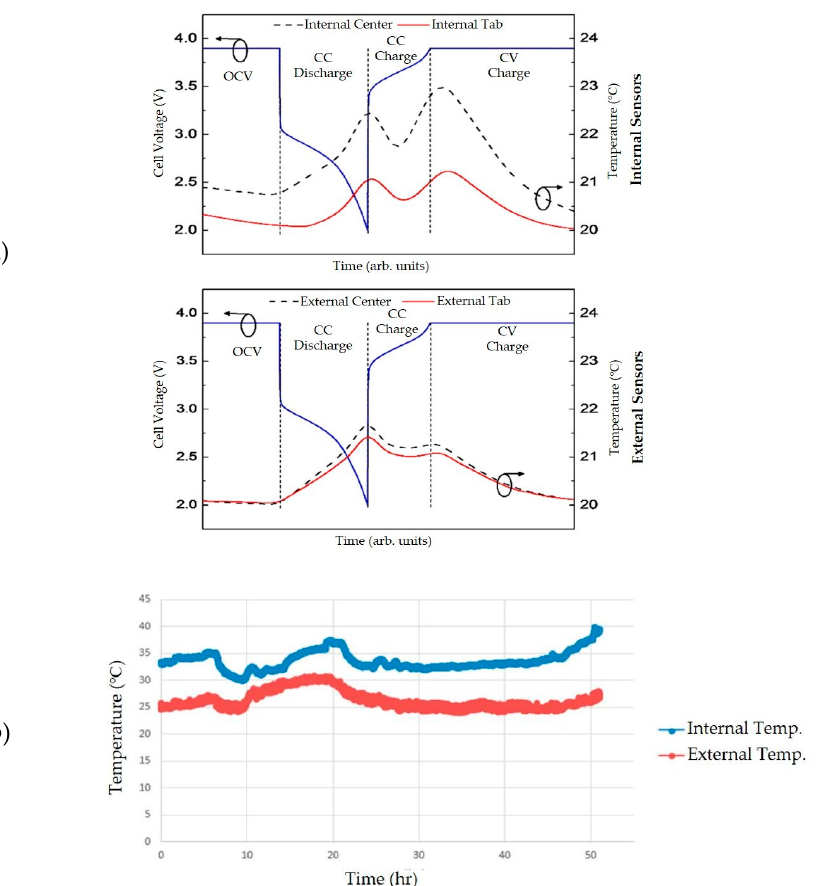
Figure 4. External vs. internal cell temperature difference by fiber Bragg grating (FBG) sensors: ( a ) temperature change from internal and external measurements of Li-ion pouch cell under 5 C-rate discharge/charge [118]; ( b ) internal cell and ambient temperature data of Li-ion coin cell under C/20 rate [119].